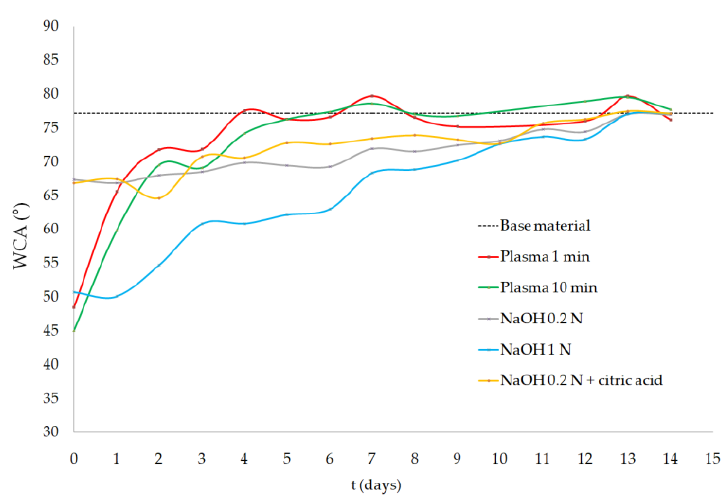
Figure 3. Water contact angle (WCA) measurements of surface-treated samples.